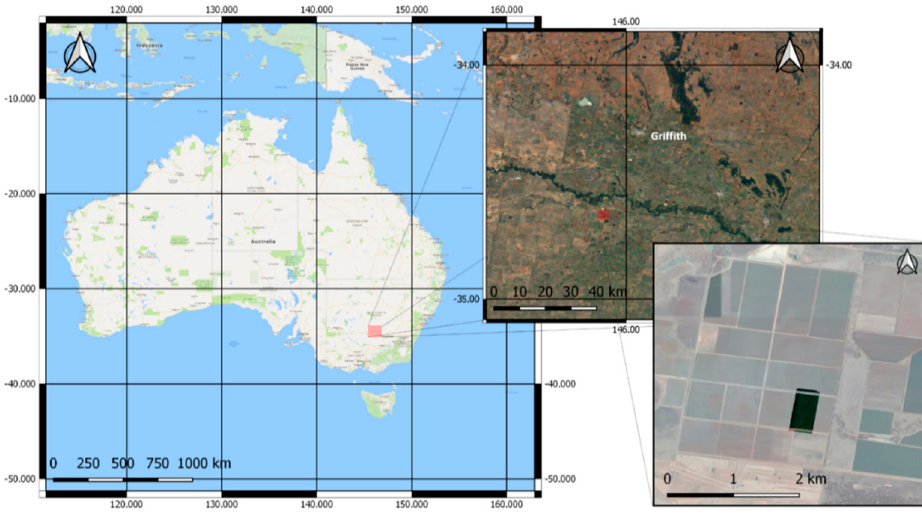
Figure 1. Location of the commercial cotton farm at Darlington Point, NSW, Australia, where the study was conducted. was